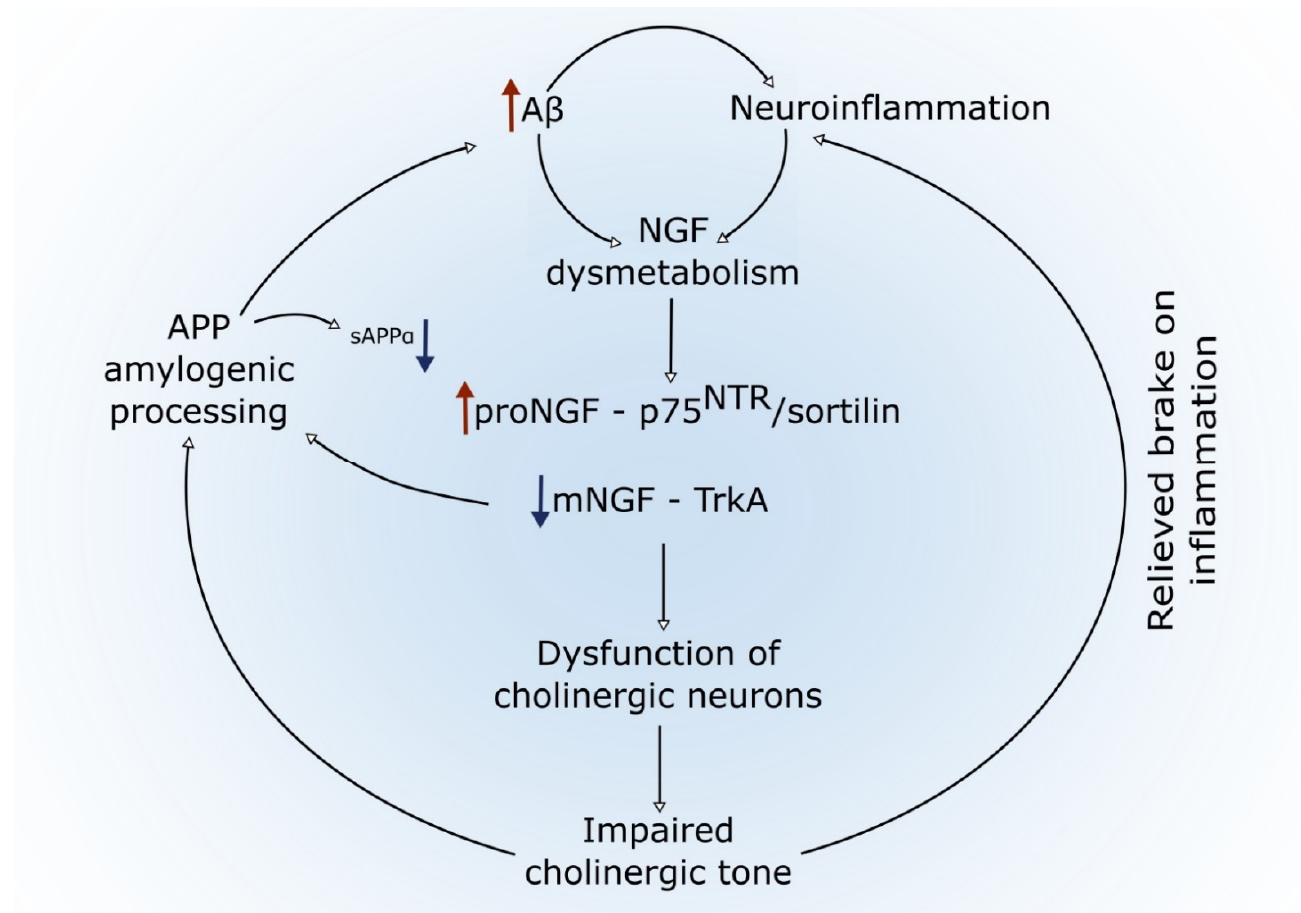
Figure 2. The proposed self-perpetuating cycle links amyloid pathology, inflammation, NGF dysregulation, and basal forebrain cholinergic atrophy. The accumulation of toxic A β peptides oligomers produced from the amyloidogenic processing of APP induces an early neuroinflammatory process as well as early NGF dysmetabolism. The latter results in an excess of proNGF and depletion of mNGF and a coincident regulation of their specific receptors. A β -driven overproduction of proinflammatory mediators can also itself lead to a dysregulation of the NGF pathway. The reduced bioavailability of mNGF then leads to diminished cholinergic trophic support resulting in BFCNs’ atrophy and loss of function. In turn, the reduced cholinergic tone further promotes amyloidogenic processing of APP, as well as neuroinflammation, given the suggested inflammatory suppressive effects of acetylcholine. Together, this leads to a self-perpetuating cycle promoting further dysfunction of the cholinergic system.